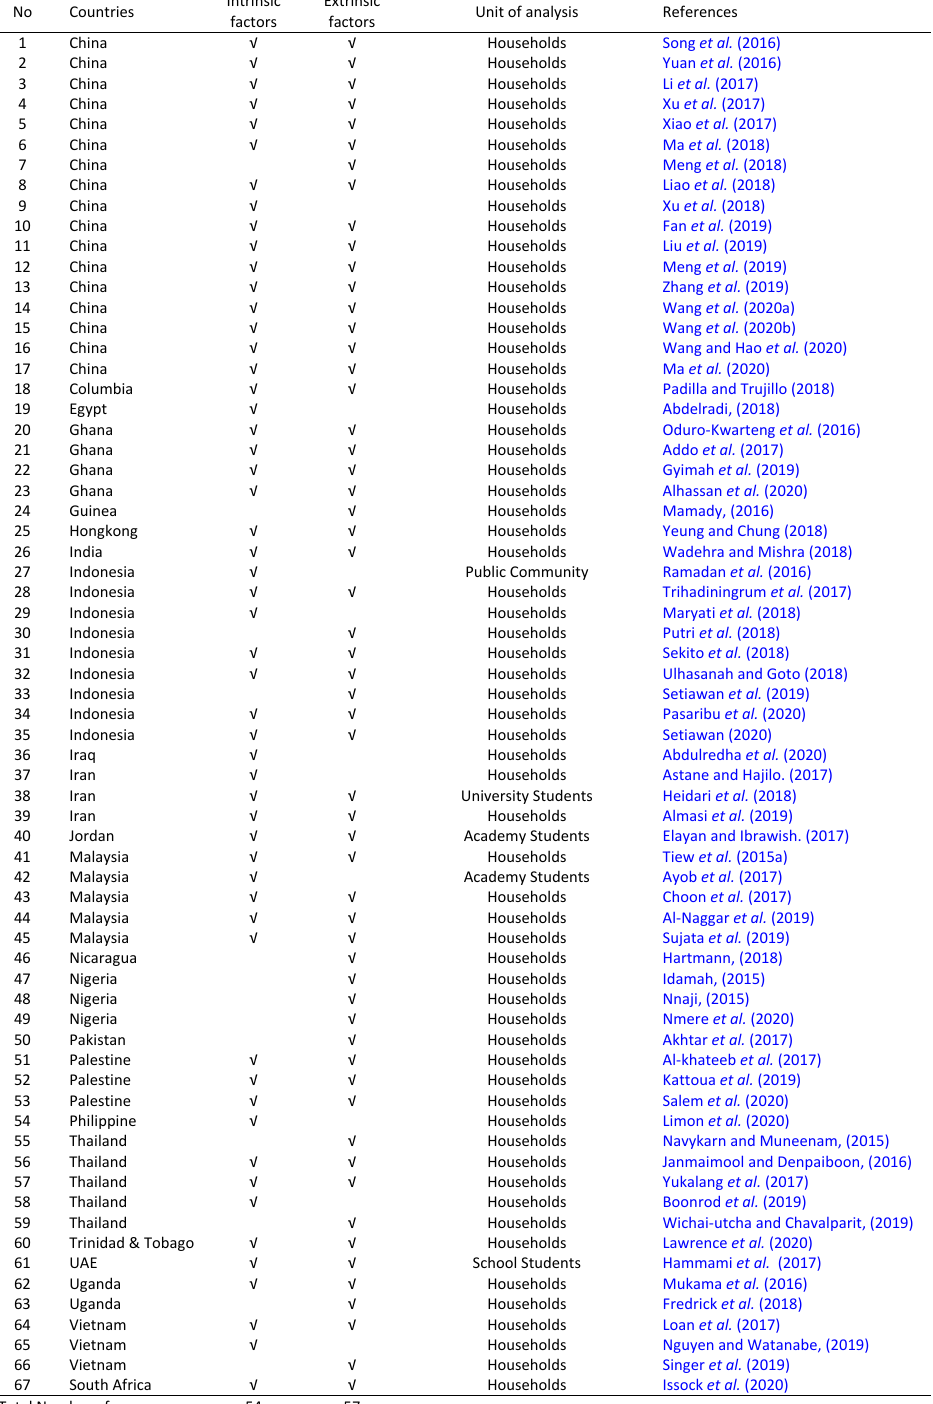
developing countries